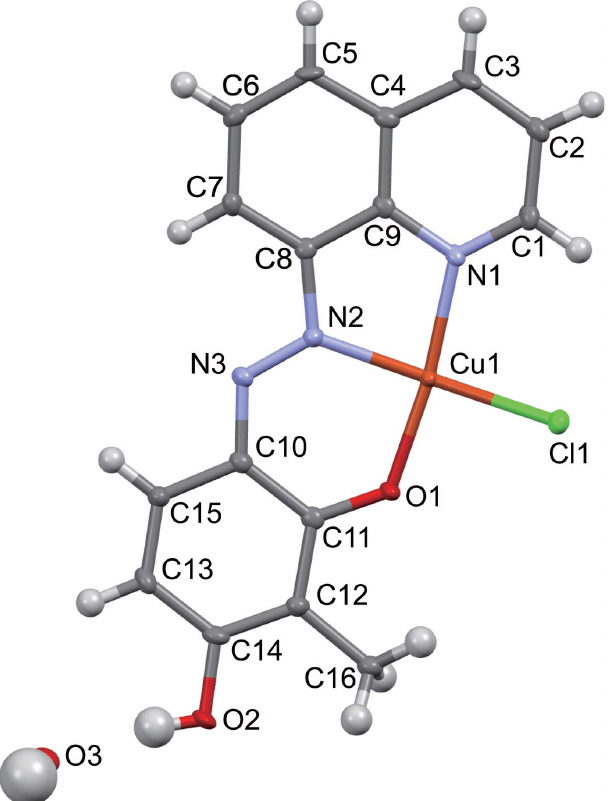
Figure 1 Crystal structure of the title compound showing the atom-labeling scheme, generated with Mercury software (Version 2021.2.0; Macrae et al. , 2020). Displacement ellipsoids are drawn at the 50% probability level.